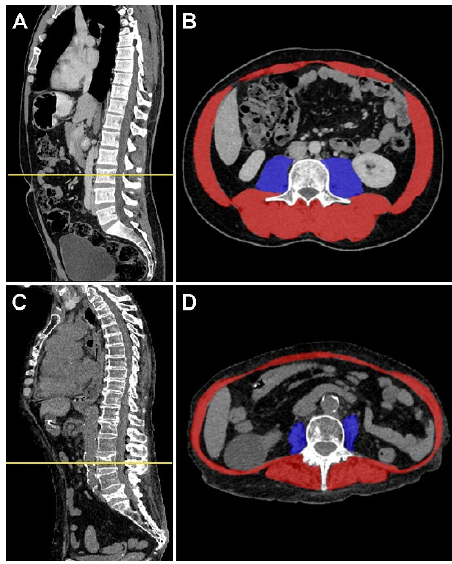
Figure 1. Automatic assessment of the muscle area on the abdominal–pelvic computed tomography scan. Sagittal views show the axial line section in the middle of the third lumbar vertebra using a deep reinforcement learning algorithm (panels ( A , C )). Panels ( B , D ) indicate the corresponding axial slice of a fit ( C ) and a sarcopenic ( D ) patient with area measurements of psoas muscle (blue) and parietal muscle (red).